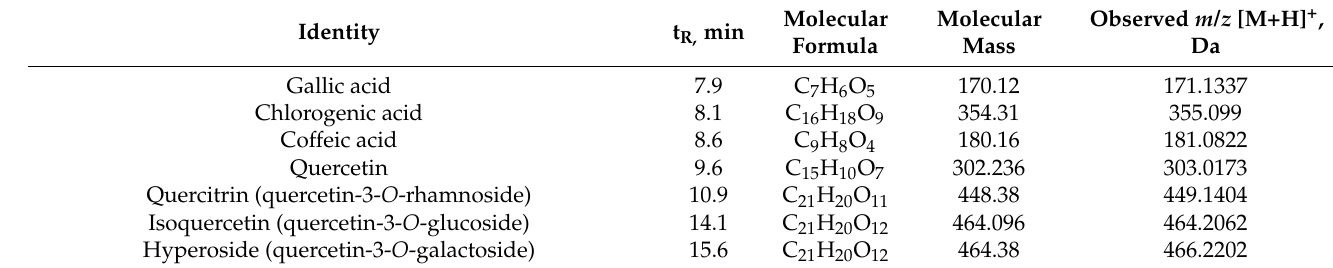
Table 3. Antioxidant activity of various R. idaeus extracts evaluated by DPPH • assay. Extracts